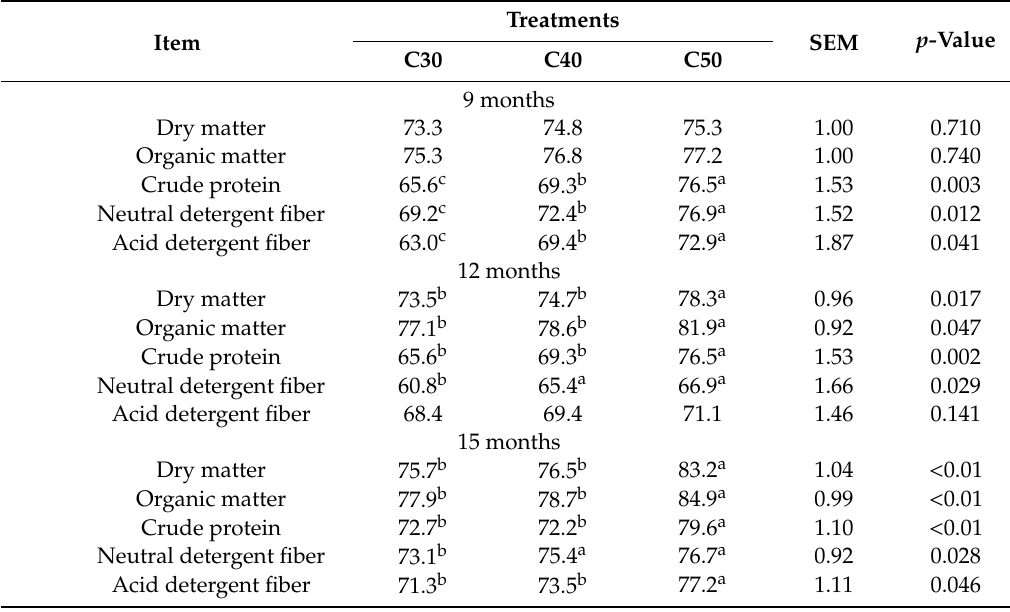
Table 3. E ff ects of di ff erent dietary concentration level on apparent nutrient digestibility of Holstein cows at age of 9, 12 and 15 months.